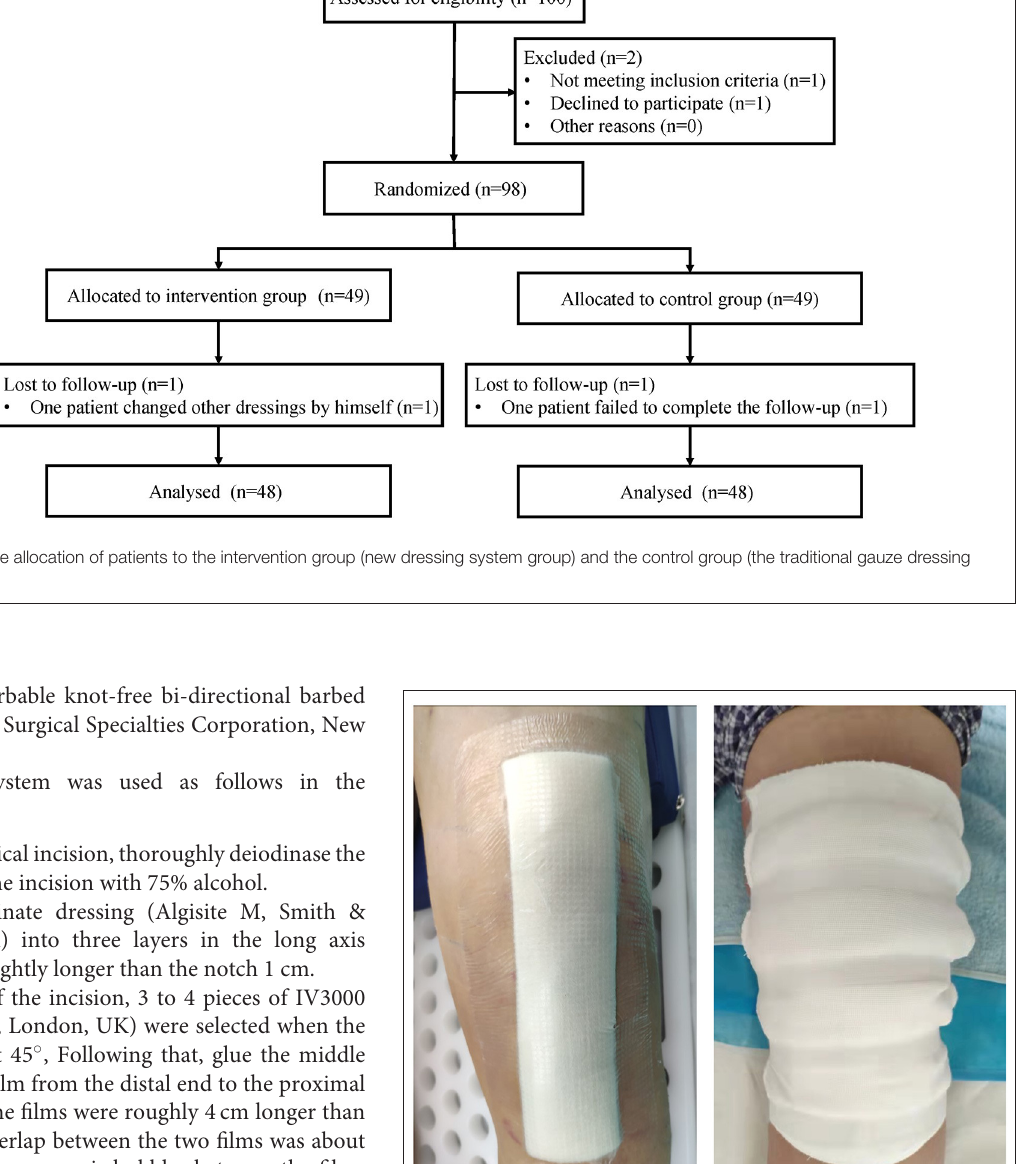
Patients using the new dressing system were allowed to bath as usual based on their lifestyle. Patients with traditional gauze dressing can only brush their bodies 2 weeks following the operation, and they are not allowed to take showers or bubble baths to avoid wetting the dressings. All patients were not covered with dressing 2 weeks after the operation. After discharge,